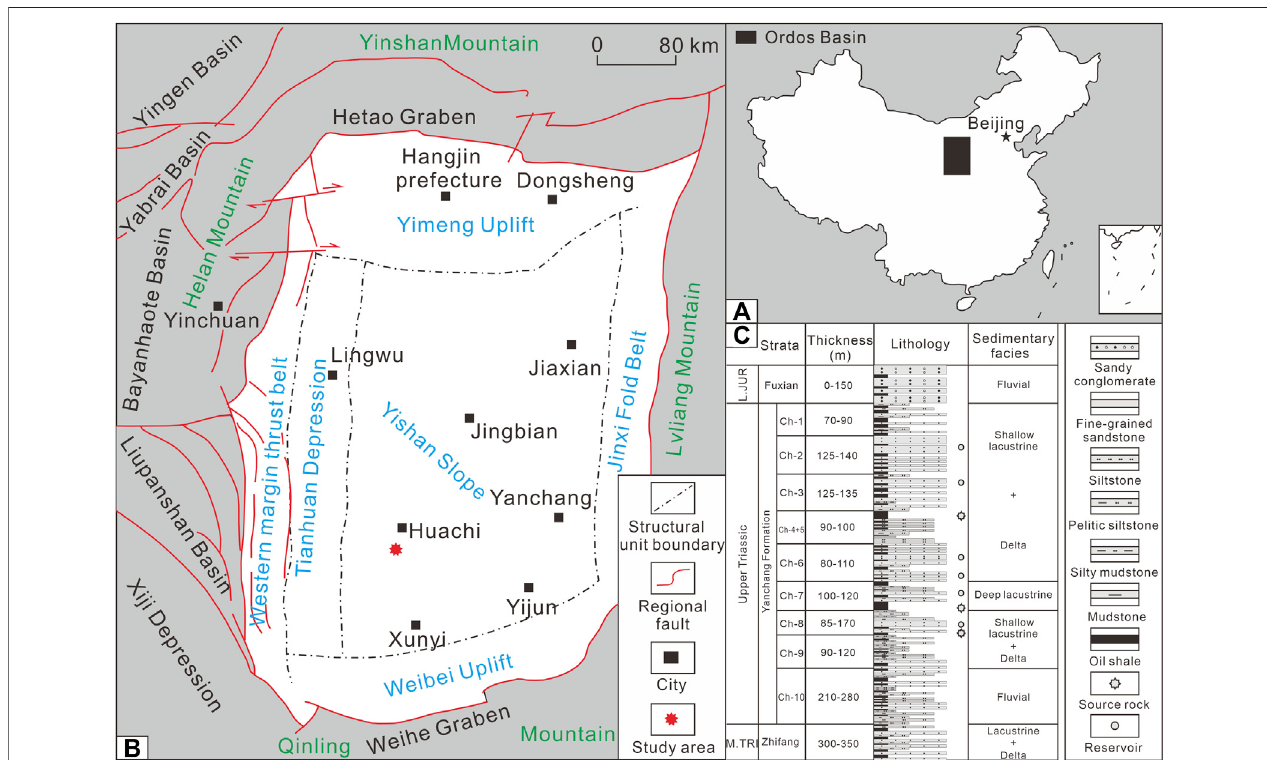
FIGURE 1 | (A) Geographicmap of the Ordos Basin; (B) Location of the Ordos Basin in China; (C) Stratigraphic characteristics of the Yanchang Formation (Wang et al., 2020).